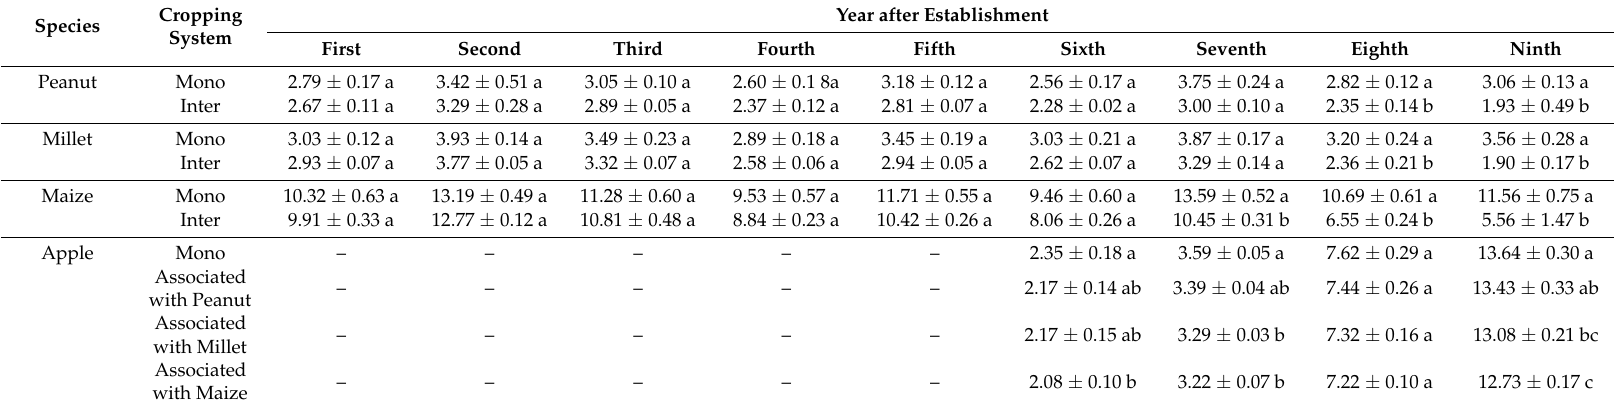
Table 1. Yields (t ha − 1 ) of apple ( Malus pumila ) and crops in alley cropping and sole crops in Exp.1 (2005–2013). The crop yields in alley cropping systems were expressed per unit of crop